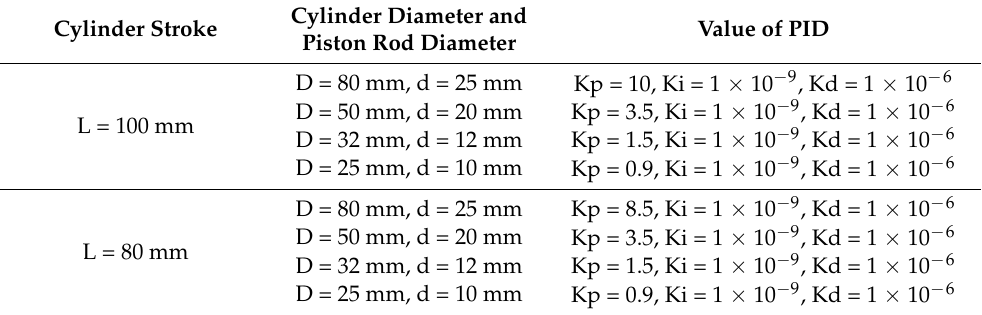
Figure 13. Response curves of different stroke positions. ( a ) Kp = 5, Ki = 1 × 10 − 9 , Kd = 1 × 10 − 6 ; ( b ) Kp = 3, Ki = 1 × 10 − 9 , Kd = 1 × 10 − 6 ; ( c ) Kp = 0.9, Ki = 1 × 10 − 9 , Kd = 1 × 10 − 6 ; ( d ) Kp = 0.9, Ki = 1 × 10 − 9 , Kd = 1 × 10 − 6 . Table 3. Values of PID for the cylinders with different structural